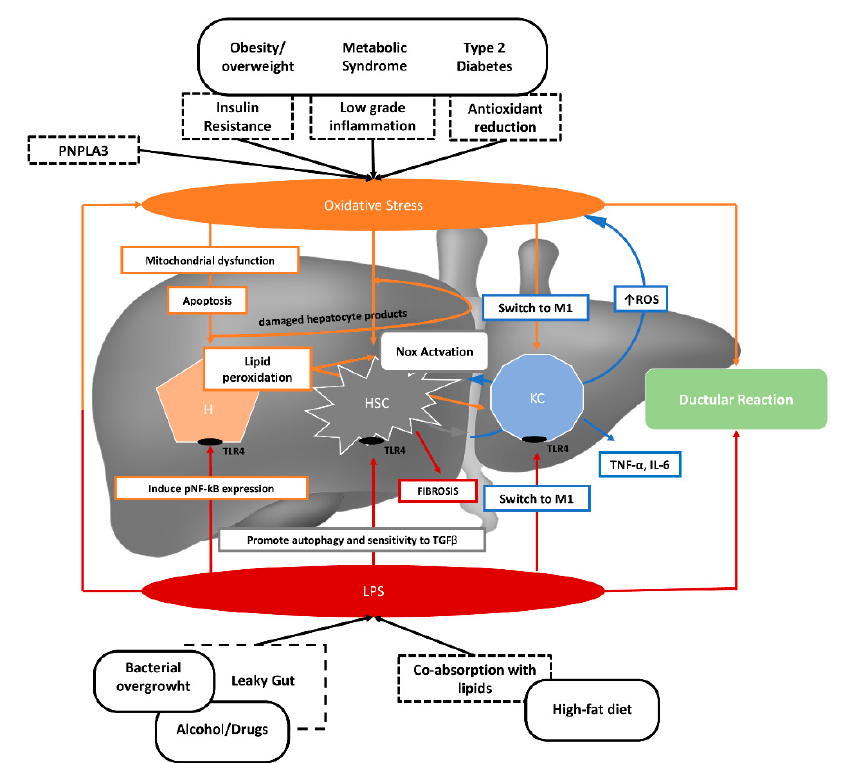
Figure 1. The role of increased serum lipopolysaccharides (LPS) and oxidative stress in the pathogenesis of non-alcoholic fatty liver disease. Dysmetabolic conditions, such as obesity, metabolic syndrome, and type 2 diabetes may induce oxidative stress as a consequence of increased insulin resistance, low-grade inflammation, and a reduction in antioxidants. Bacterial overgrowth, excessive alcohol consumption, and a diet rich in fat may induce increased intestinal LPS translocation. Oxidative stress and LPS promote hepatocellular damage, as well as hepatic stellate cell and Kupfer cell activation. PNPLA3: Patatin-like phospholipase domain-containing protein 3; Nox: NADPH oxidase; M1: M1 macrophages; ROS: Reactive oxygen species; HSC: Hepatic stellate cell; KC: Kupfer cell; TLR4: Toll-like receptor 4; pNF- κ B: Phosphorylated nuclear factor κ B; TNF- α : Tumor necrosis factor α ; IL-6: interleukin 6; TGF β : Transforming growth factor β